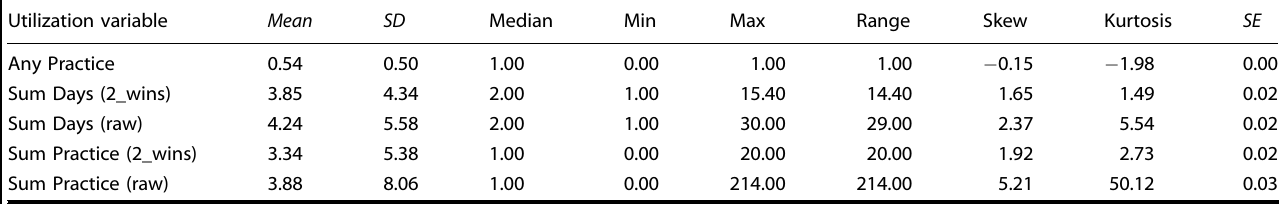
Table 2. Descriptive statistics for HMP utilization